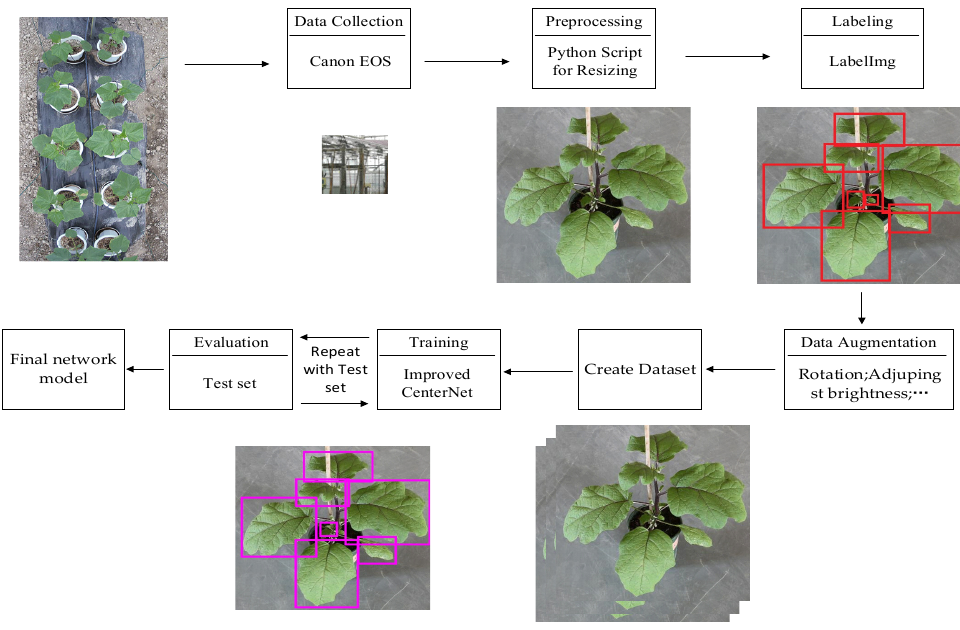
Figure 6. Overall processing flow chart.